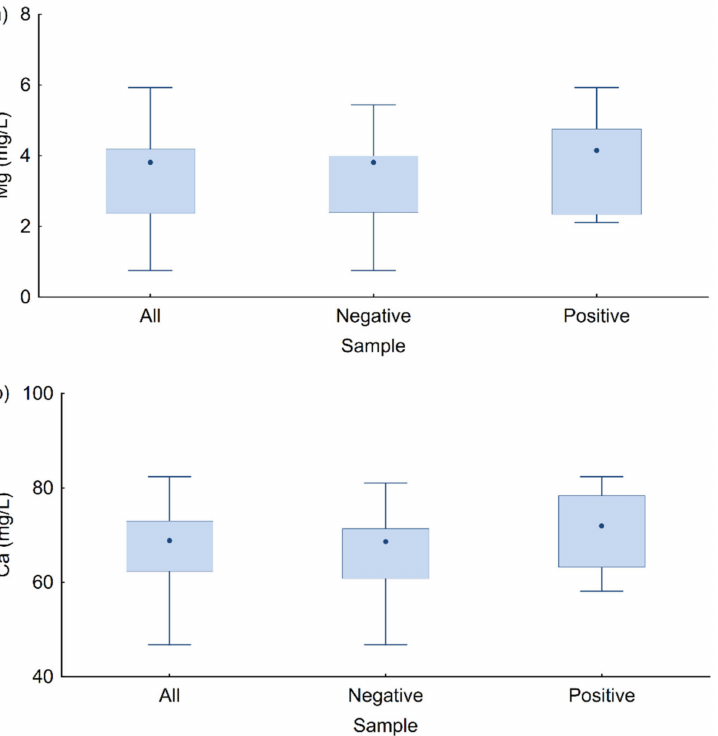
Figure 5. Interquartile representation of concentration of ( a ) Mg ion and ( b ) Ca ion, for all hot water samples and for samples with negative and positive findings of L. pneumophila .